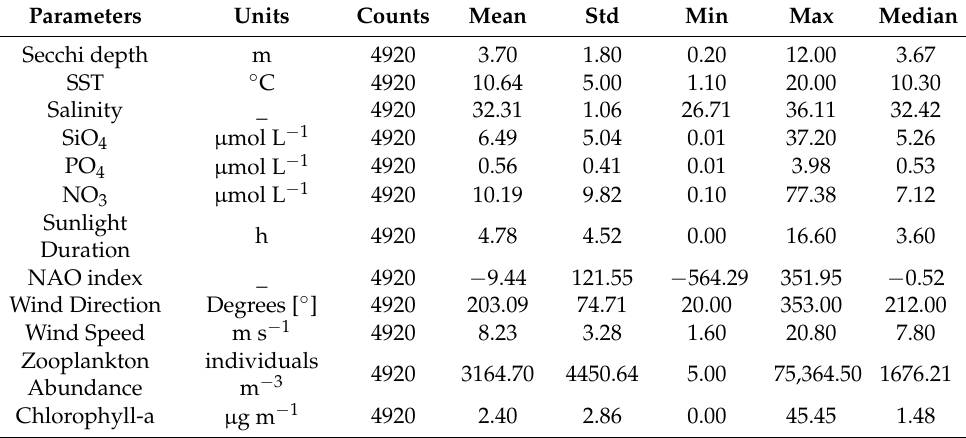
Table 1. Statistical description of parameters used as determinants to predict chlorophyll-a concen- tration (target) after linear interpolation (std, min and max are standard deviation, minimum and maximum values, respectively).